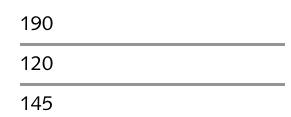
Table 14. Data on patients in Thai outreach programmes in three Asian countries